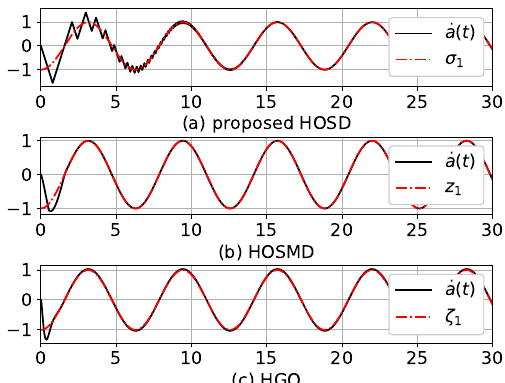
Figure 2. Estimations of ˙ a using parameter set 1 (cid:13) in Table 1.